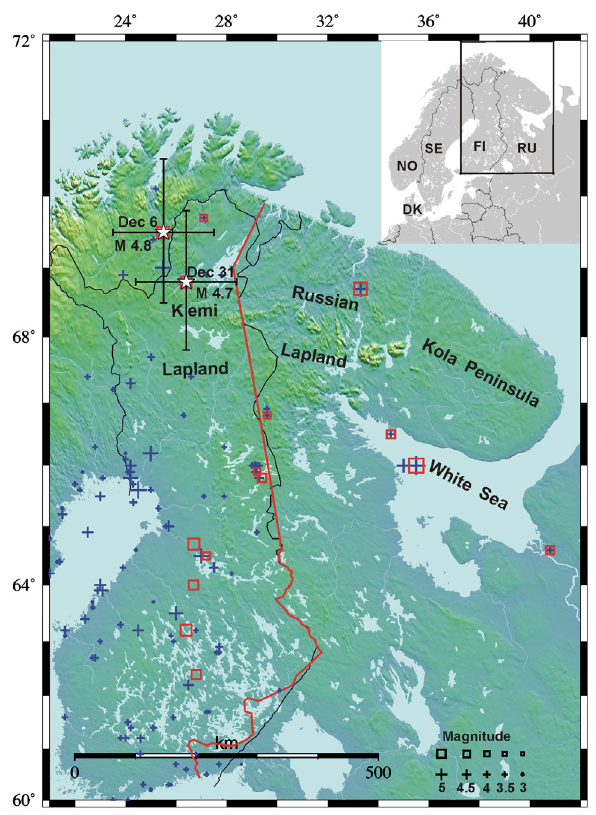
Figure 1 (left). Historical seismicity in the study region from 1542 to 1899. Earthquake epicenters were taken from the parametric cata- logs of Kondorskaya and Shebalin [1977, 1982] (squares) and Ahjos and Uski [1992] (crosses). Symbol size is scaled to earthquake mag- ≥ 4 are plotted. Stars are nitude. Only earthquakes with M ≥ 3 or I 0 earthquake epicenters from Kondorskaya and Shebalin [1977, 1982] for Dec. 6 (M = 4.8) and Dec. 31, 1758 (M = 4.7); error bars corre- spond to location accuracy. Black lines are current state borders, while the thick red line approximates the border between the Kingdom of Sweden and Russia according to the Turku peace treaty in